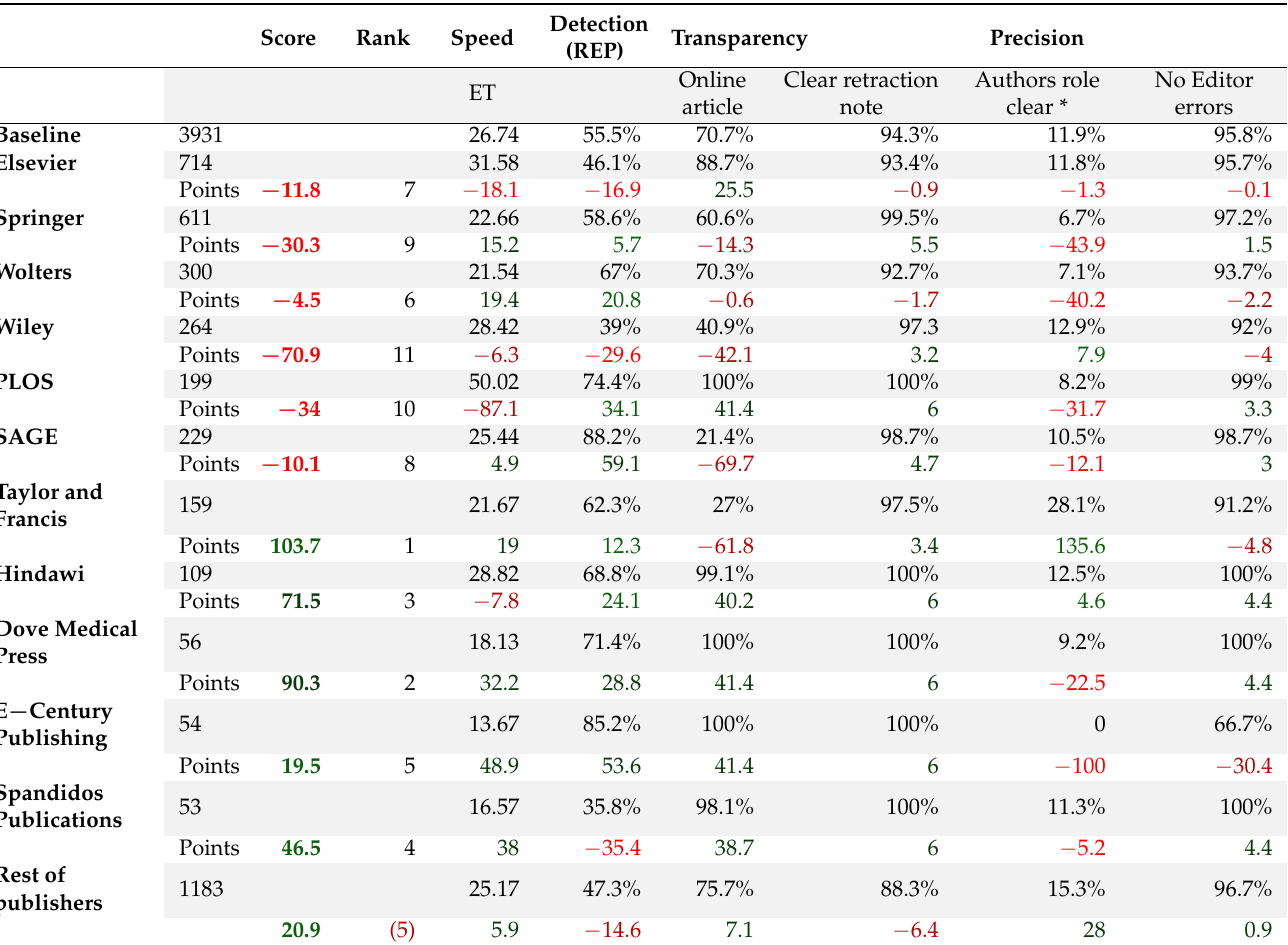
Table 13. SDTP scores and rank for the period 2009–2019 (n = 3931). * Calculated for 3569 articles with more than one author and no editorial error as retraction reason.